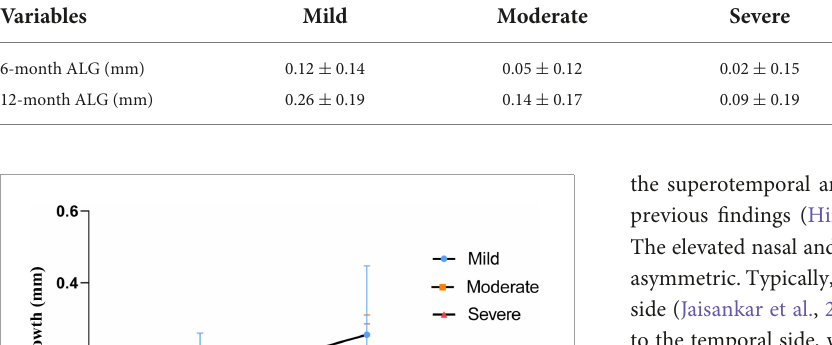
TABLE 2 Axial length growth (ALG) in different groups.